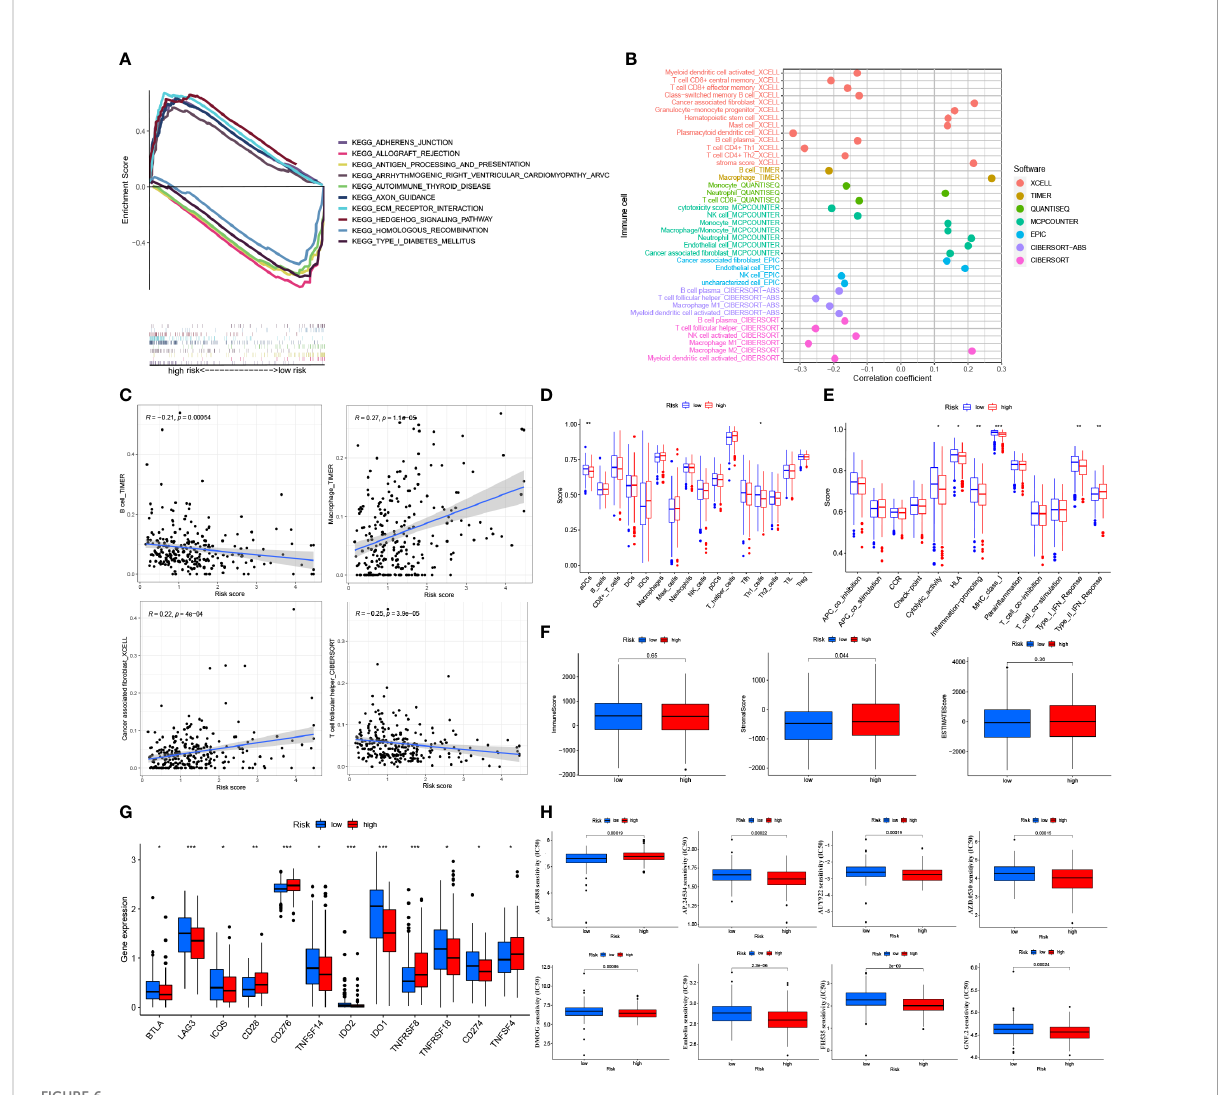
FIGURE 6 Tumor immune factors and drug sensitivity analysis in risk model (A) Kegg Pathway analysis between low- and high-risk. (B) The bubble plot of immune cells in the risk model. (C) The Relationship between immune cells and risk score (D) . (E) The ssGSEA scores for immune cells and immune function in the risk groups. (F) The association of immune-related scores between low- and high-risk groups. (G) Immune checkpoints expression in risk groups. (H) Drug sensitive analysis in the risk model. *: p < 0.05. **: p < 0.01. ***: p <